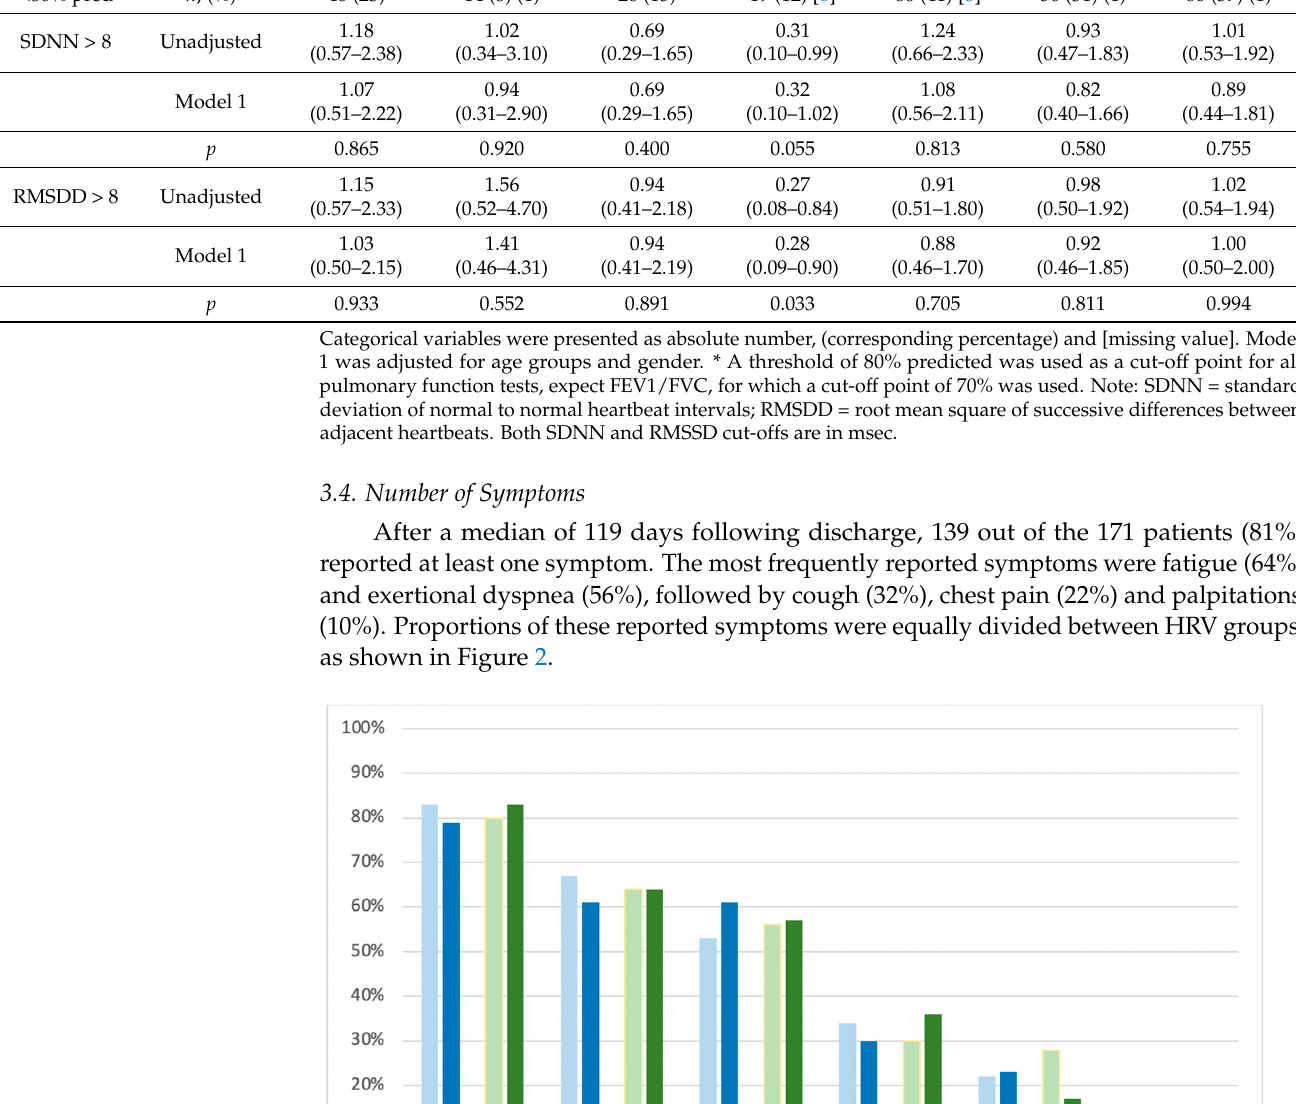
Table 3. Odds ratios with confidence intervals for symptom experience between 3 and 5 months after hospitalization with COVID-19 using multinomial logistic regression. Number of Symptoms